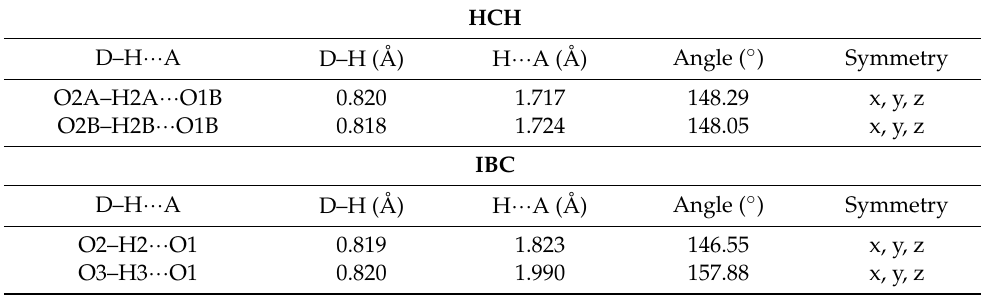
Table 2. Specification of intermolecular hydrogen bonds observed in the HCH and IBC